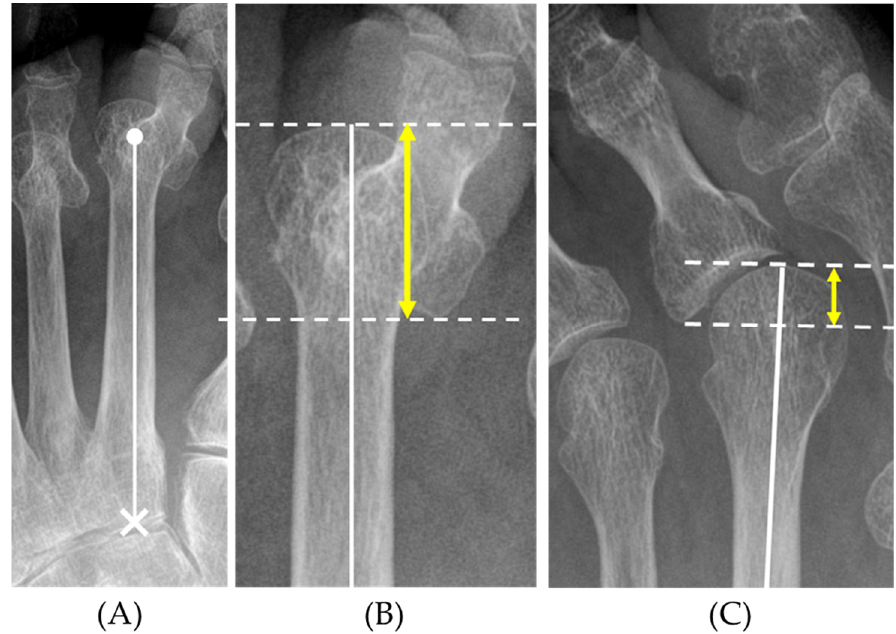
Figure 2. Definition of the MOD on plain radiographs. The metatarsal axis was defined as the line through the center of the metatarsal head ( ● ) and the center of the proximal joint surface (×) ( A ). The MOD ( ↔ ) was defined as the distance between the tip of the metatarsal head and the most proximal point of the base of the proximal phalanx along the metatarsal axis ( B ). The MOD also reflects varus or valgus deformity to some extent ( C ). MOD: metatarsophalangeal overlap